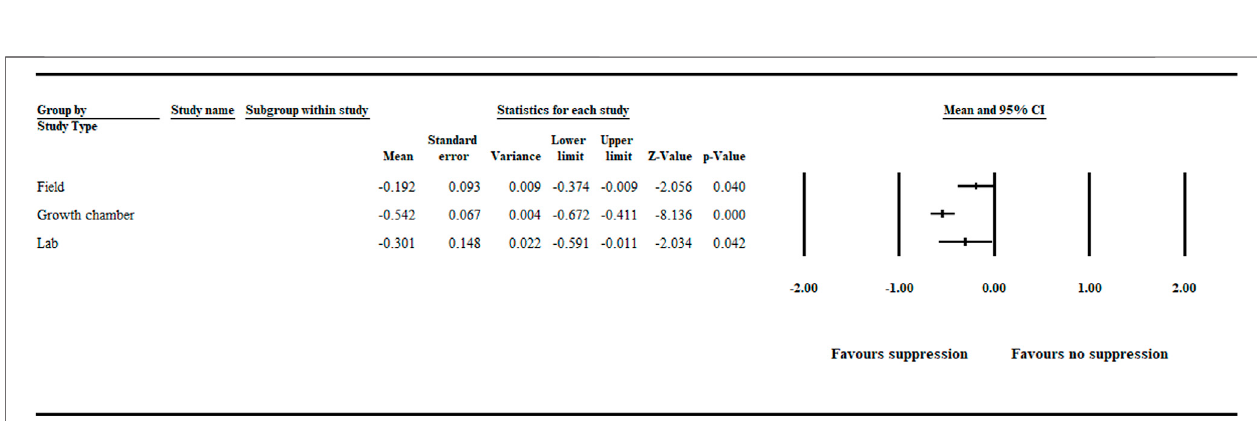
FIGURE6| Studytypeimpactonaphanomycesrootrotsuppression.Theanalysisdetectedasigni fi cant( p < .05)negativeeffectsizeforlab,growthchamber,and fi eld studies. Number of studies: Lab 20; Growth chamber 101; Field 41. The center of the horizontal line depicts the effect size, and the width re fl ects its con fi dence interval. CI (cid:1) con fi dence